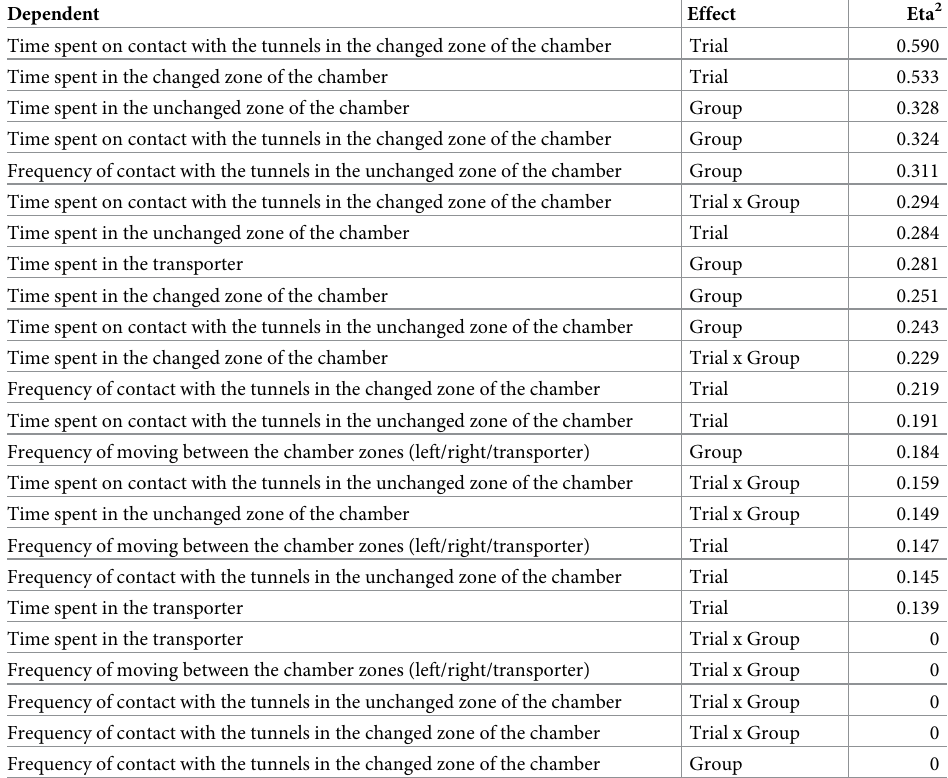
Table 2. The ranking list of statistically significant effects based on the partial Eta 2 values. The Eta 2 values of sta- tistically non-significant effects have been set to “0”. Dependent Effect Eta 2